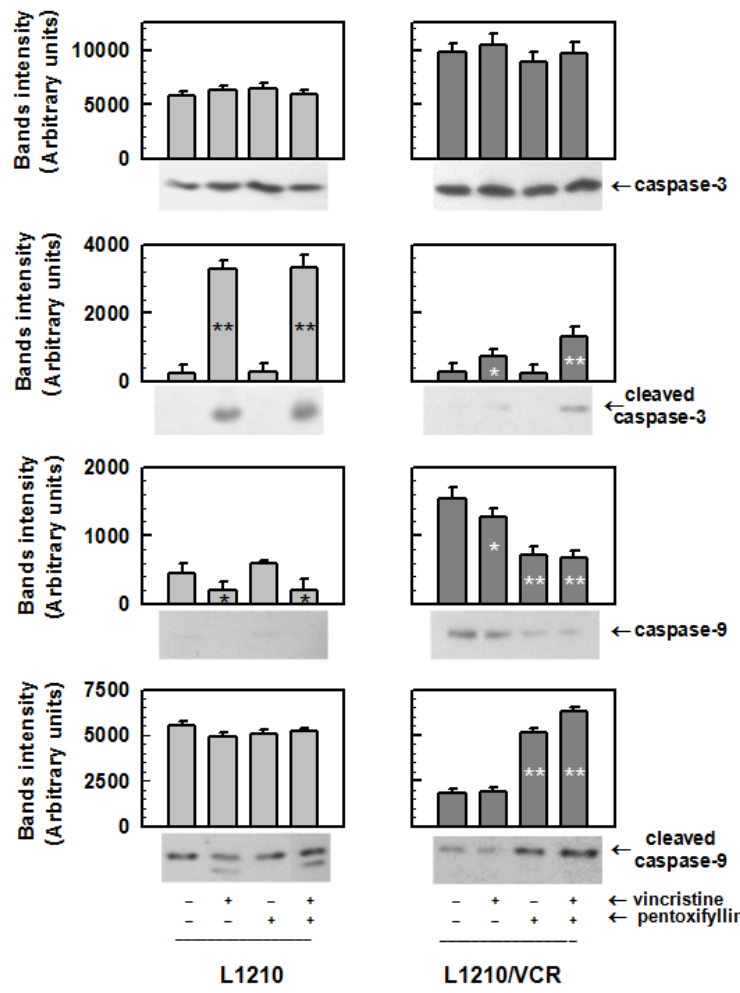
Figure 3. Effect of VCR and PTX treatment on caspase-3 and caspase-9. The sensitive L1210 and resistant L1210/VCR cells were treated with VCR (1.2 μmol/L) and/or PTX (100 μmol/L) for 24 h. The protein levels of full-length and cleaved caspase-3 and caspase-9 were determined by Western blot analysis using specific antibodies. Blots of three independent experiments were quantified and obtained data were evaluated by Student’s t test. * And ** different from control (without drugs) at significance level p < 0.01 and p < 0.05,